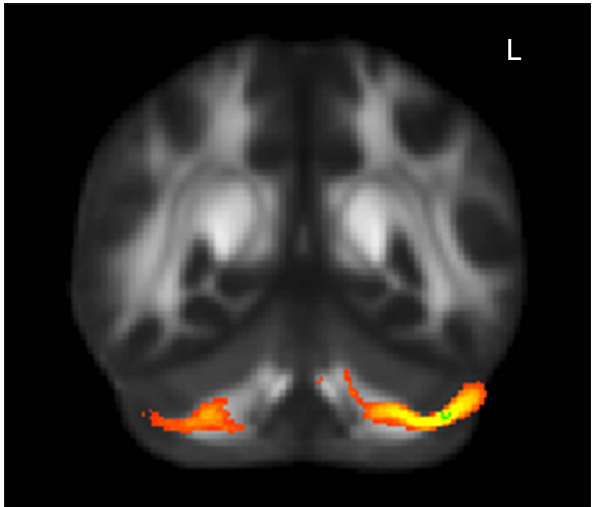
Figure 3. FA skeleton regions where orienting ratio scores showed a significant positive correlation with FA maps (p , 0.05, corrected). The regions in red circle were identified as the right superior longitudinal fasciculus (SLF) and white matter beneath the right precuneus and inferior frontal gyrus, respectively. The coordinates are in MNI standard space. R, right hemisphere."